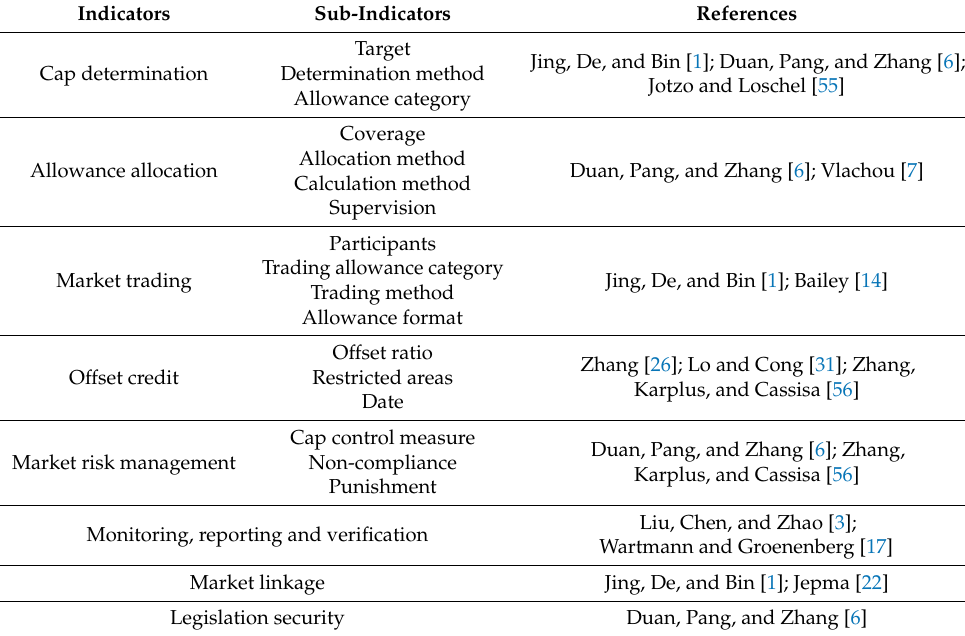
Table 2. Comparative indicators and